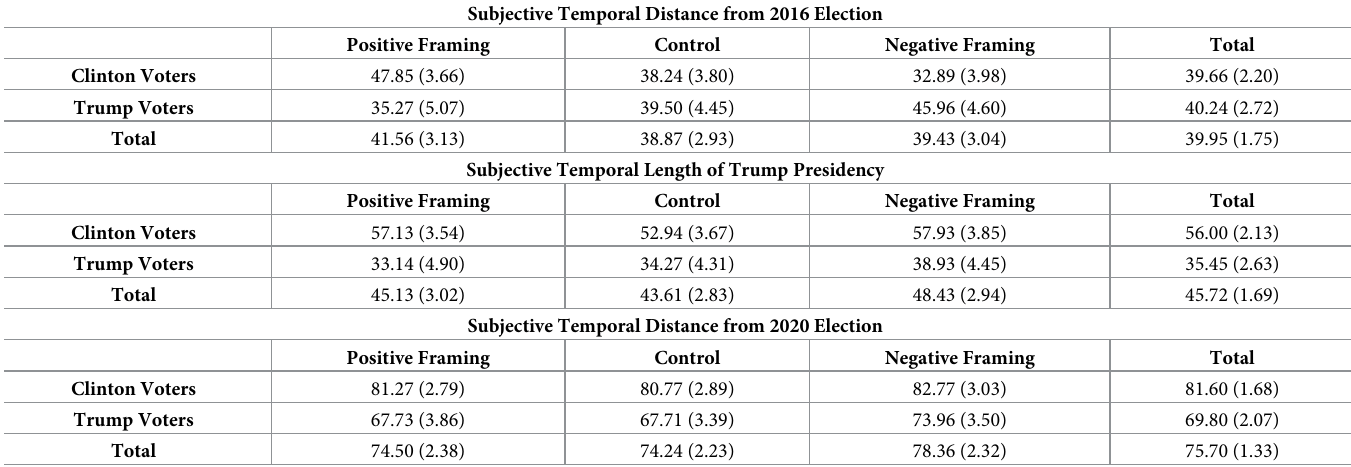
Table 2. Estimated marginal means and standard errors by cell for measures of subjective temporal